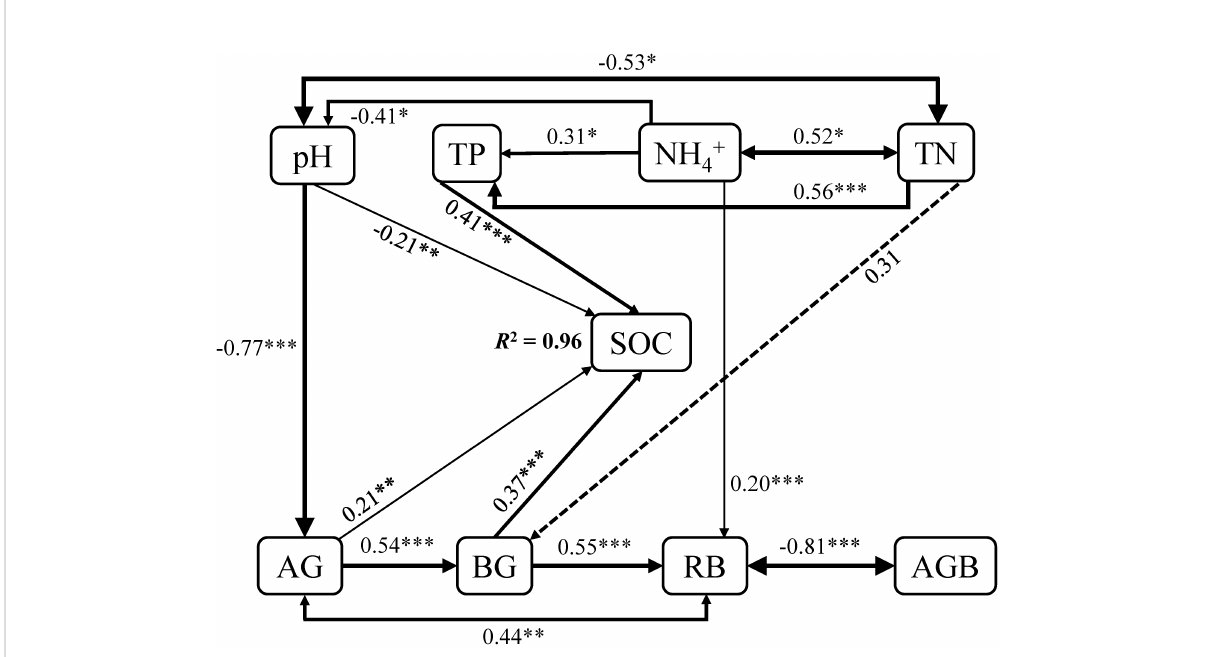
FIGURE 6 Path analysis showing the effects of pH, TP, NH 4+ , TN, AG, BG, as well as RB and AGB on SOC. The fi nal path analysis adequately fi tted the data c 2 = 28.55, df = 20, P = 0.10, GFI = 0.83, AIC = 78.55, RSME = 0.001. Solid and dashed arrows suggest signi fi cant and non-signi fi cant paths, respectively. The width of the solid arrows indicates the strength of the relationships. R 2 shows the proportion of SOC explained by variables. Signi fi cant level: * P < 0.05; ** P < 0.01; *** P <